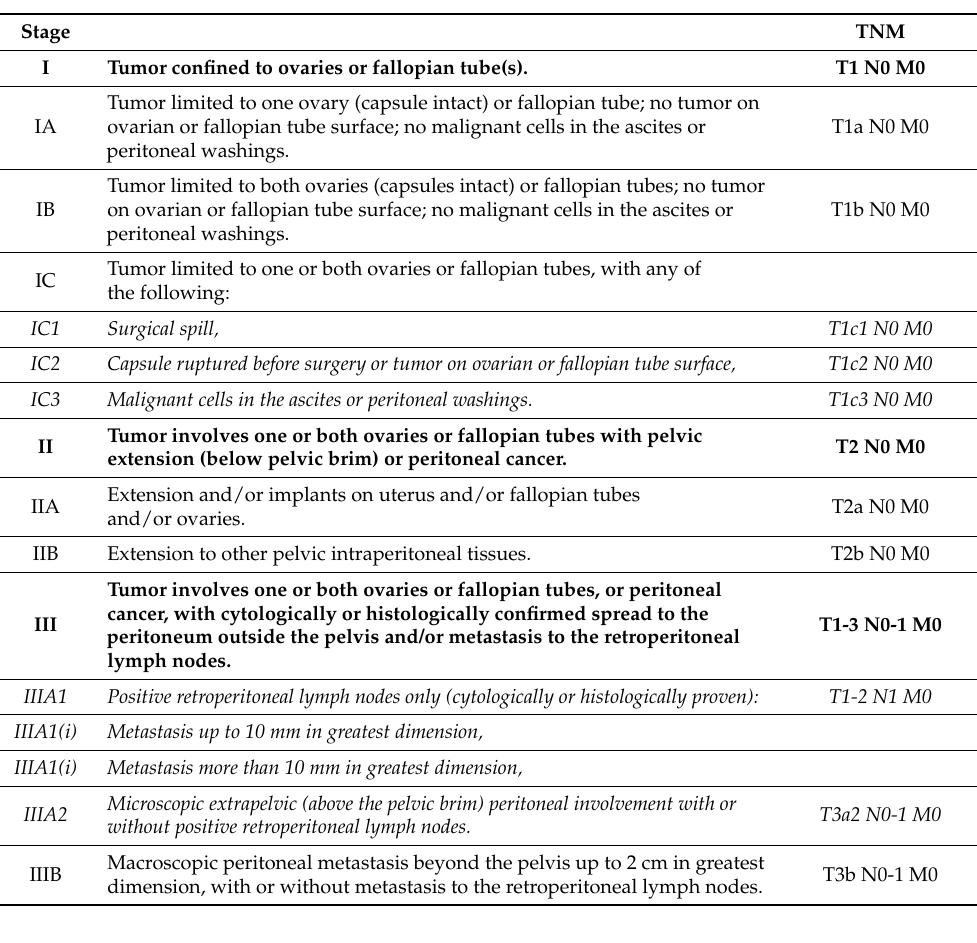
Table 1. FIGO staging classification for cancer of the ovary